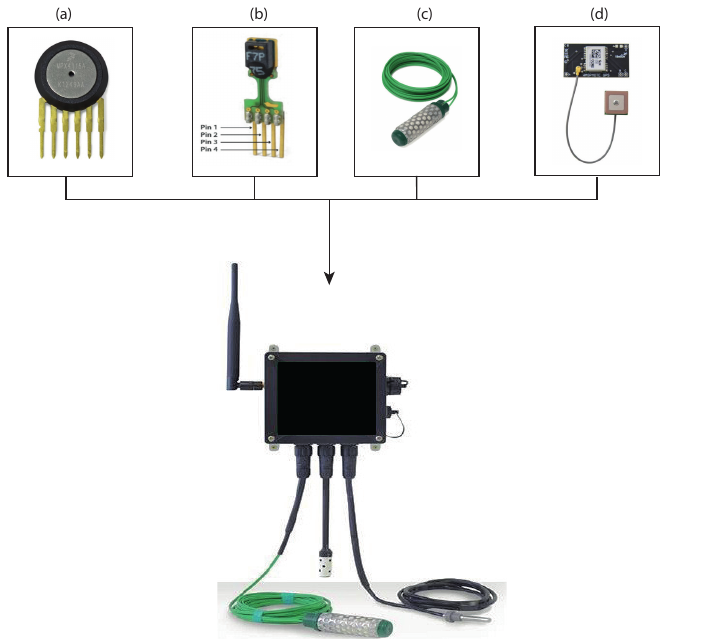
Figure 6. Sensors: atmospheric pressure ( a ), temperature and humidity ( b ), soil moisture ( c ) and GPS ( d